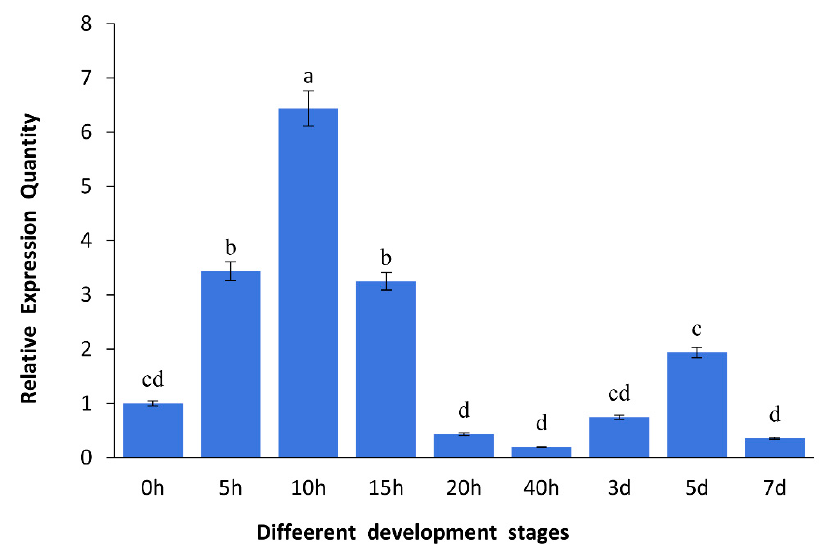
Figure 1. Quantitative real-time qPCR analysis of the expression levels of As– RAD9 in different developmental stages of A. sinica . The 0h stage expression level of As –RAD9 was set as a control group, and the mRNA expression levels of As– RAD9 at different time points during development was measured. The x-axis represents the various phases (0 h to 7 days), and the y-axis represents the expression level relative to 0 h. Data are mean ± SD of three replicate experiments, and significant differences in different developmental stages ( P < 0.05) were analyzed by one-way ANOVA and are indicated by lower case letters (a–d).